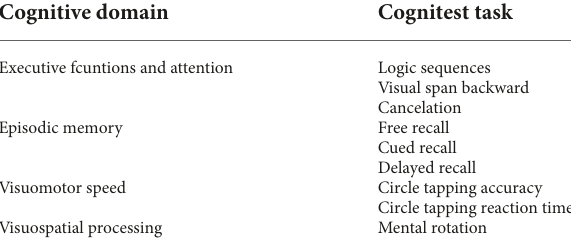
TABLE 3 Principal components structure for the Cognitest